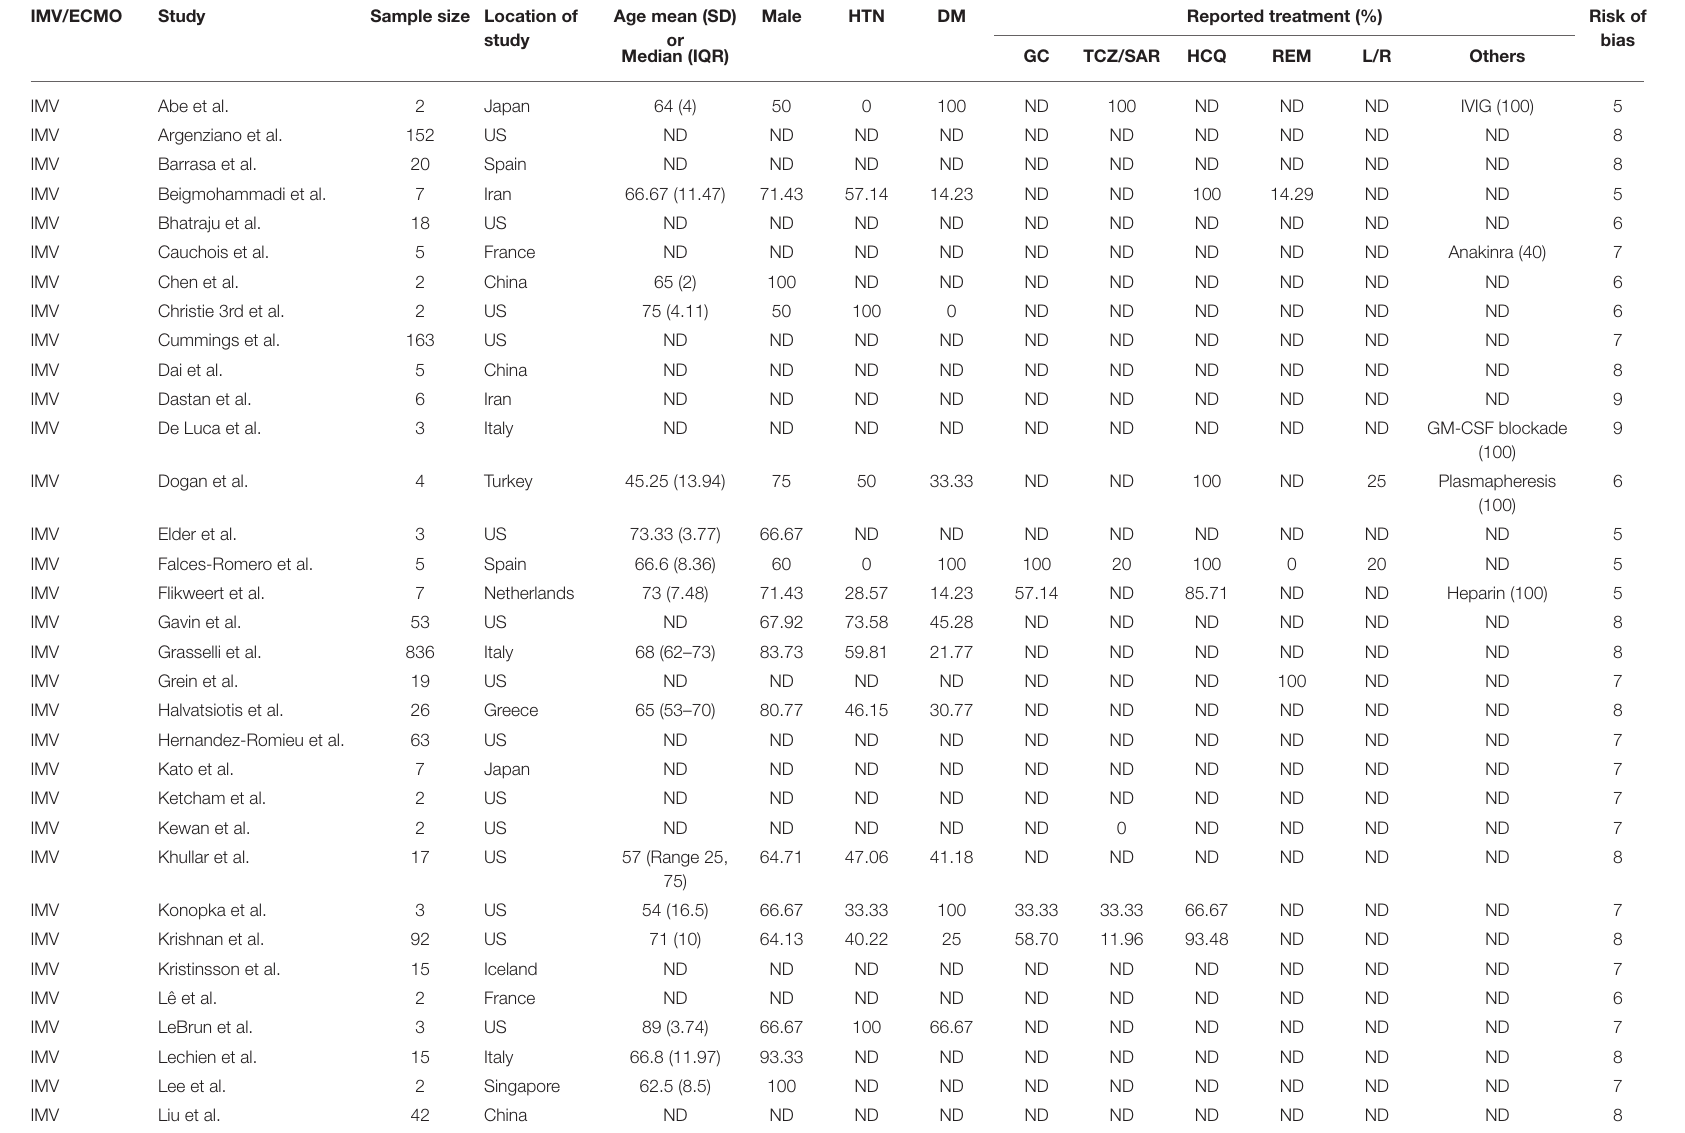
TABLE 1 | Background of critical COVID-19